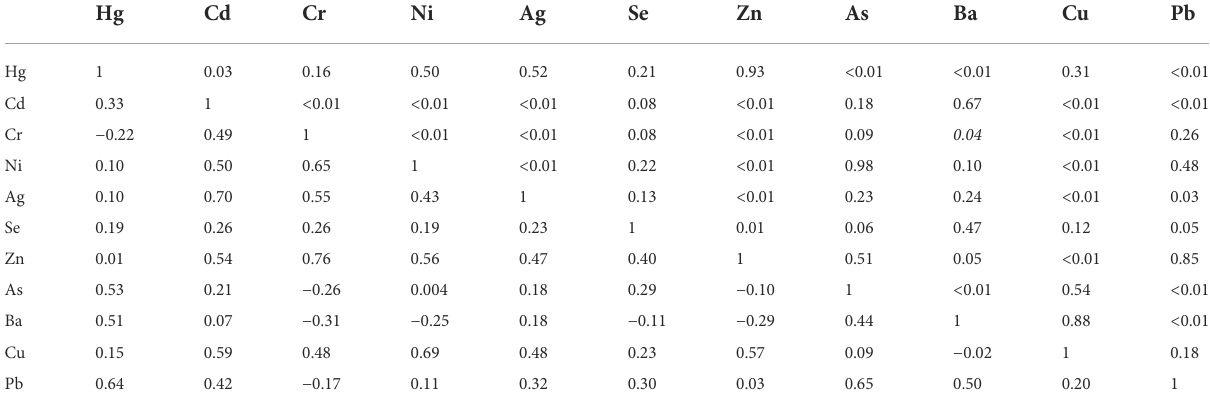
TABLE 3 Pearson ’ s correlation matrix.